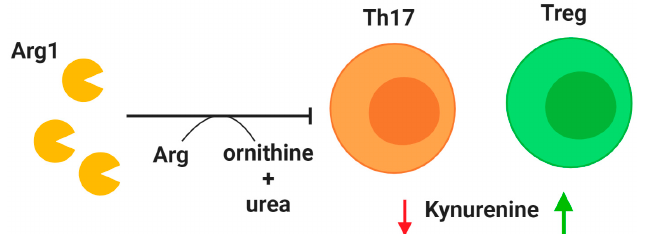
Figure 2. Modulation of T cell activity. Arginase 1 (Arg1) is secreted by neutrophils upon granule exocytosis and has a potent inhibitory effect on T cells in the lung by cleaving the essential amino acid arginine (Arg) to produce ornithine and urea. A deficiency of regulatory T cells (Tregs) in CF patients may be explained by reduction of indoleamine 2,3 ‐ dioxygenase (IDO). Mouse models have demonstrated that correction of IDO deficiency by administration of kynurenines can rectify T cell imbalance by promoting Treg populations. Decreased availability of kynurenine (red arrow) reduces T helper type 17 (Th17) populations, while increased availability (green arrow) promotes Treg phenotype.